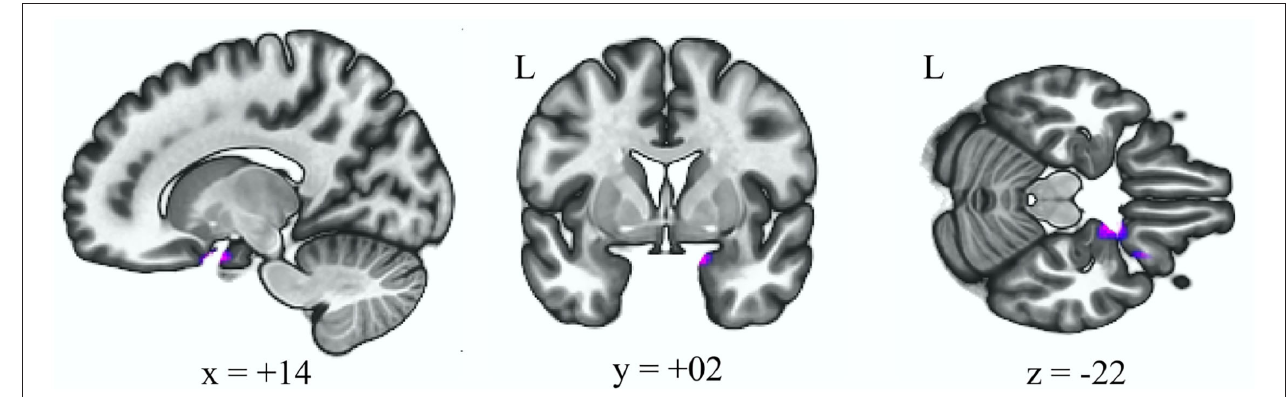
FIGURE 3 | Decreased functional connectivity with the anterior cerebellum as the seed ROI ( p < 0.05, p-FDR-corrected) in the HFS group vs. HC group. L, left; ROI, region of interest; HFS, hemifacial spasm; HC, healthy